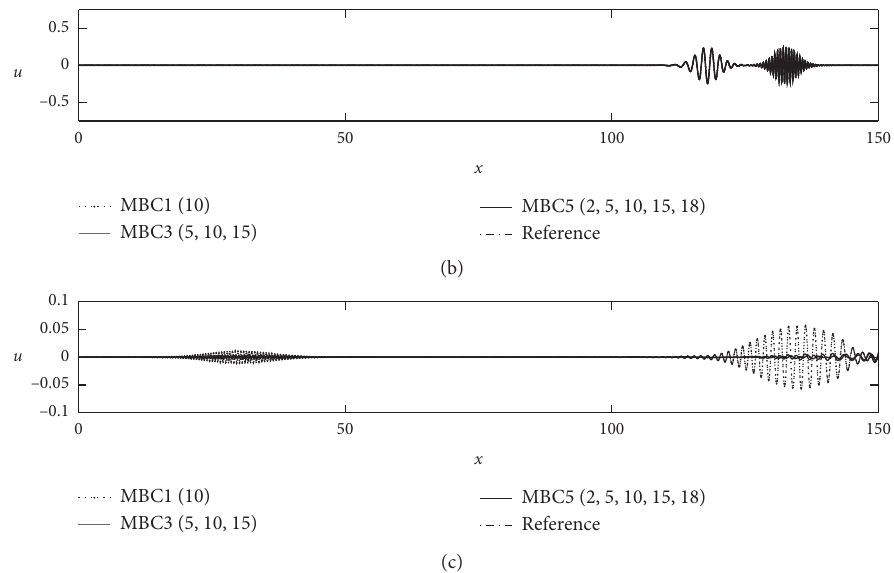
Figure 12: Time evolution of the waveform with two major wave numbers k � 4 and 12: (a) t � 0, (b) t � 1.0, and (c) t � 6.0.